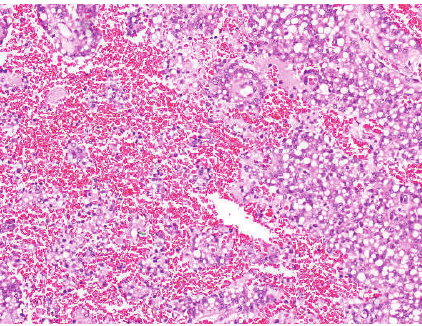
Figure 6: Haematoxylin and eosin stained sections displaying highly vascular and haemorrhagic stroma. Loosely cohesive cellular clusters are seen scattered within the stroma ( × 400).